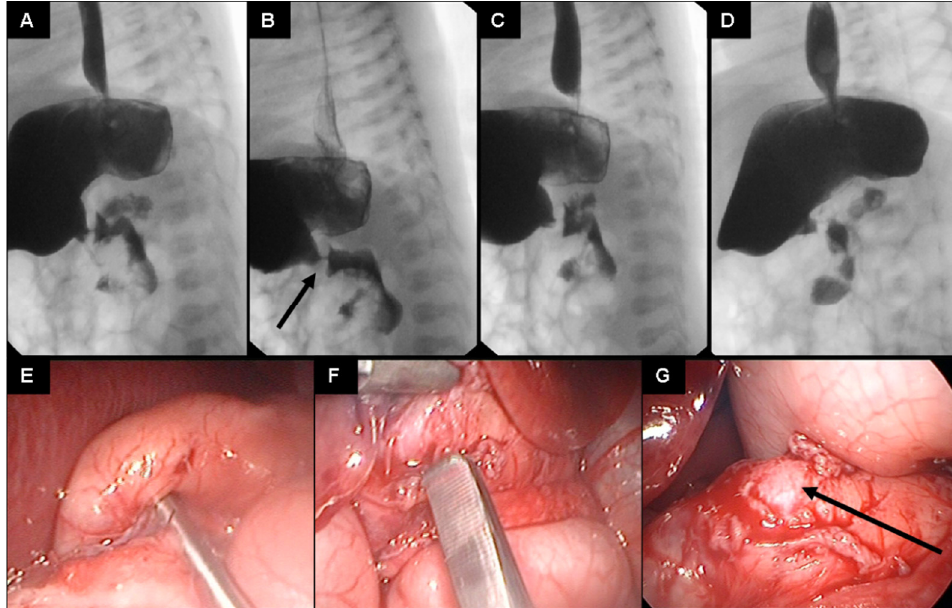
Figure 2. ( A – G ): Sequences of the upper gastrointestinal contrast study ( A – D ) of the presented preterm infant on day 6 of life (a water-soluble nonionic gastrointestinal radiopaque agent was used). A narrowed pyloric canal presenting as a typical “string sign” is seen (arrow in ( B )). Only a minimal passage of the contrast agent is seen during the 20 min duration of the study. Intraoperative pictures showing congenital hypertrophic pyloric stenosis ( E ) and pyloromyotomy ( F , G ) (arrow pointing at pyloric mucosa).